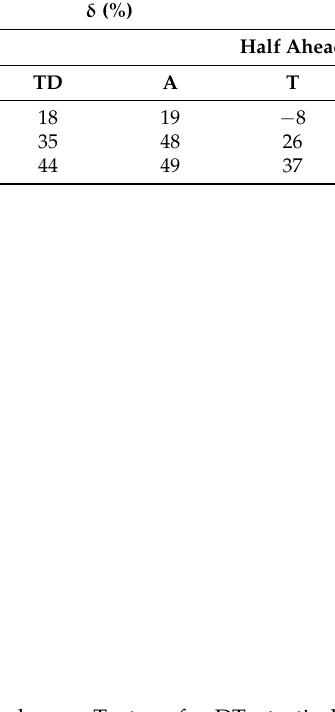
Figure 7. Parameters of the turning circle trial: A—advance, T—transfer, DT—tactical diameter.